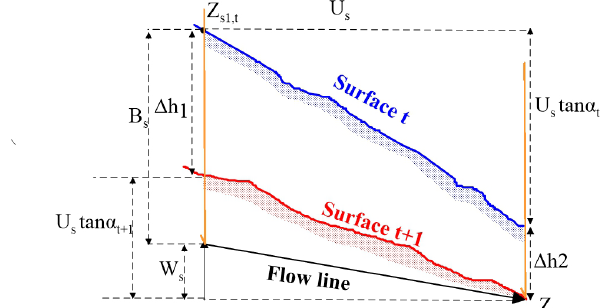
Figure 3. Diagram illustrating horizontal, vertical and emergence velocities (ma − 1 ) observed from an ablation stake (orange). U s (ma − 1 ) and W s (ma − 1 ) are the components of horizontal and ver- tical velocities, α t and α t + 1 are the slopes for the years t and t + 1, respectively, Z s1 ,t and Z s2 ,t + 1 are the elevations of the surface at each end of the ice flow vector, and (cid:49)h 1 and (cid:49)h 2 are the elevation changes (m) at each end of the ice flow